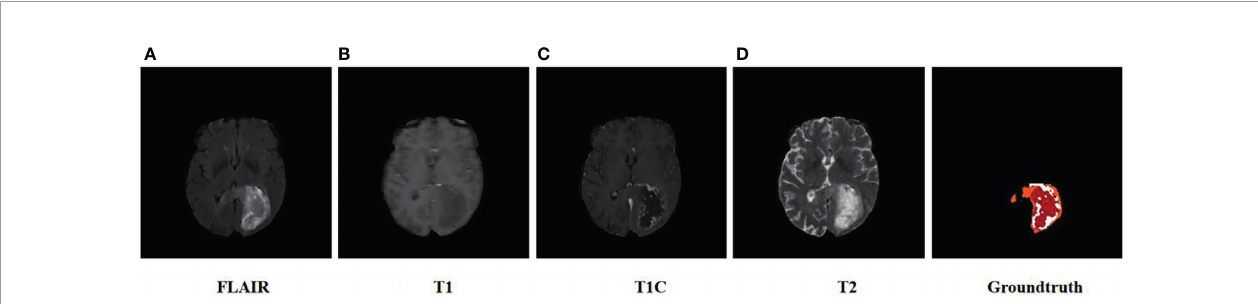
FIGURE 5 | Schematic diagram of the BRATS 2018 training dataset. From left to right are (A) FLAIR, (B) T1, (C) T1-c, and (D) ground truth, where the colors of the ground truth represent categories of tumor segmentation: orange represents edematous regions, red represents enhancing tumors, and white represents necrotic and nonenhancing tumors.